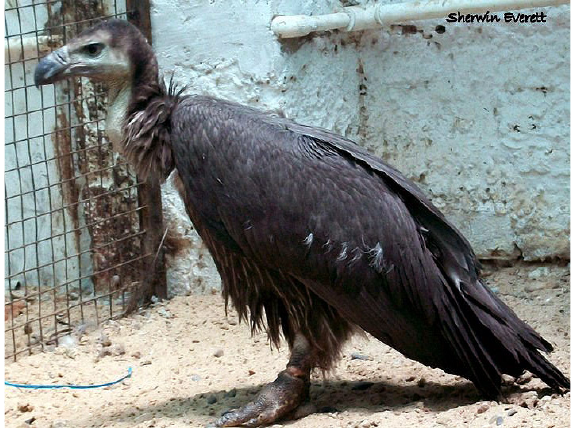
Image 9. Leg fracture is not caused by kite string